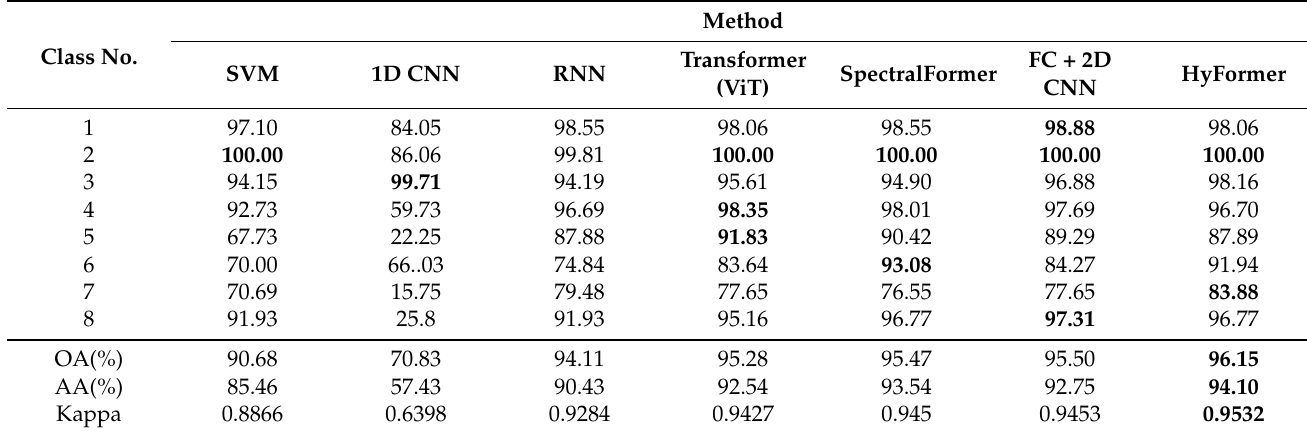
Table 12. Comparison of classification results of different classification methods applied on the testing set of Changxing County, 2020.